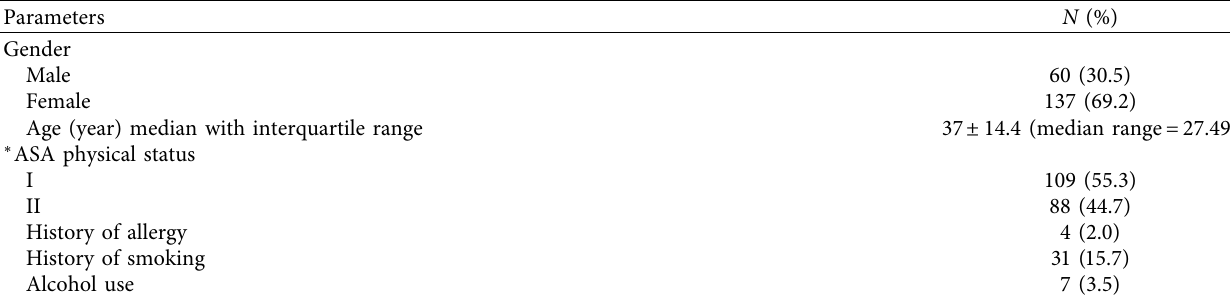
Table 1: Demographic, allergic, and history of substance use of the respondents ( N � 197).